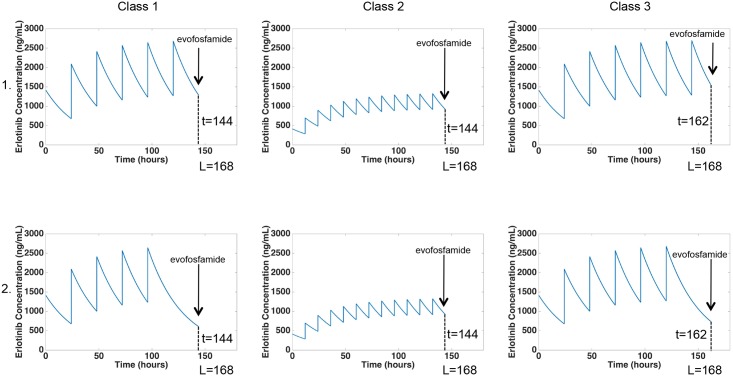
Example depicting dose schedule definition for one cycle of treatment with n = 3 for all optimization classes.This schematic shows the process by which one cycle of treatment is defined for each optimization class with n = 3. A cycle in Class 1 or 3 contains a standard erlotinib dosing schedule of 150 mg/day, whereas a cycle in Class 2 contains a low-dose erlotinib schedule of 7 mg twice daily. When n = 3, each cycle has length L = 168 (one week). For Classes 1 and 2, the evofosfamide dose in each cycle is given 24 hours before the end of the week, and for Class 3 the evofosfamide dose in each cycle is given 6 hours before the end of the week. This is all depicted in step 1. Step 2 shows the removal of erlotinib doses required to satisfy the combination toxicity constraint. Each of these cycles is then repeated to form the entire dosing schedule.